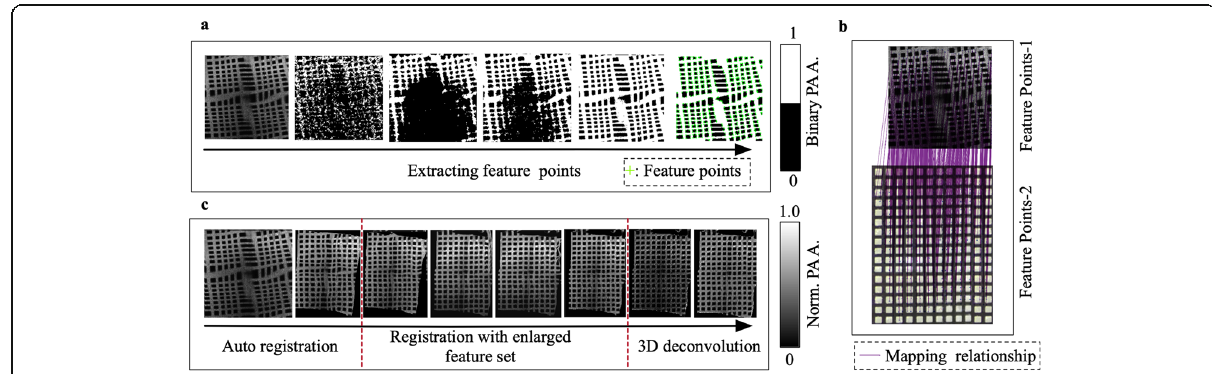
Fig. 3 Stage results of SWM construction with a resolution chart. a : The process of extracting feature points by utilizing OV-MRF and H&SA; b : The mapping relationship between the feature points-1 (the feature points in the input image) and the feature points-2 (the feature points in reference image); c : The process of image registration based on the feature point pairs; stage results after the first red dashed line are obtained by adding manually selected feature points for registration, and stage results after the second red dashed line are 3D deconvolution results. Norm.: Normalized; PA A.: Photoacoustic